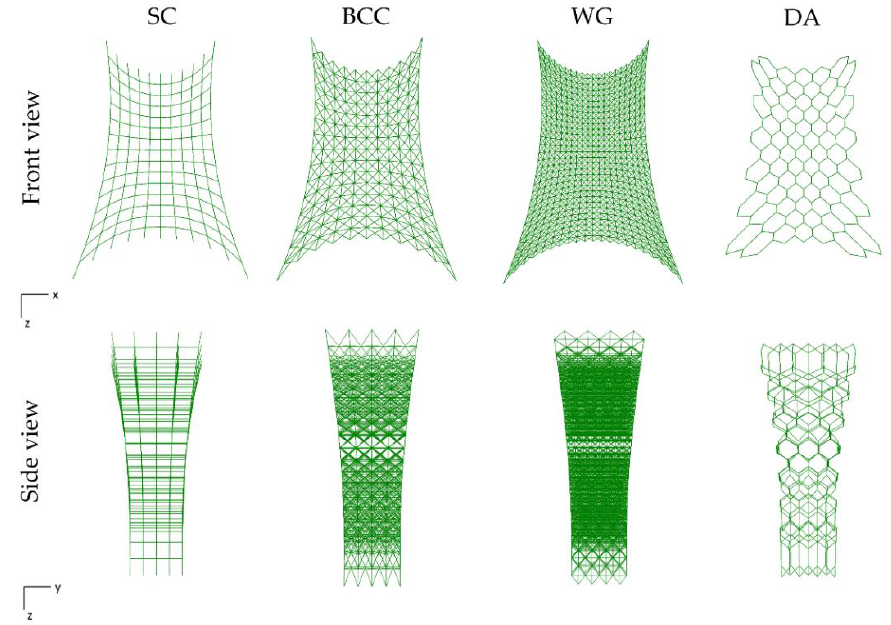
Figure 5. Conformal wireframe obtained by the NURBS-FFD modeling method.